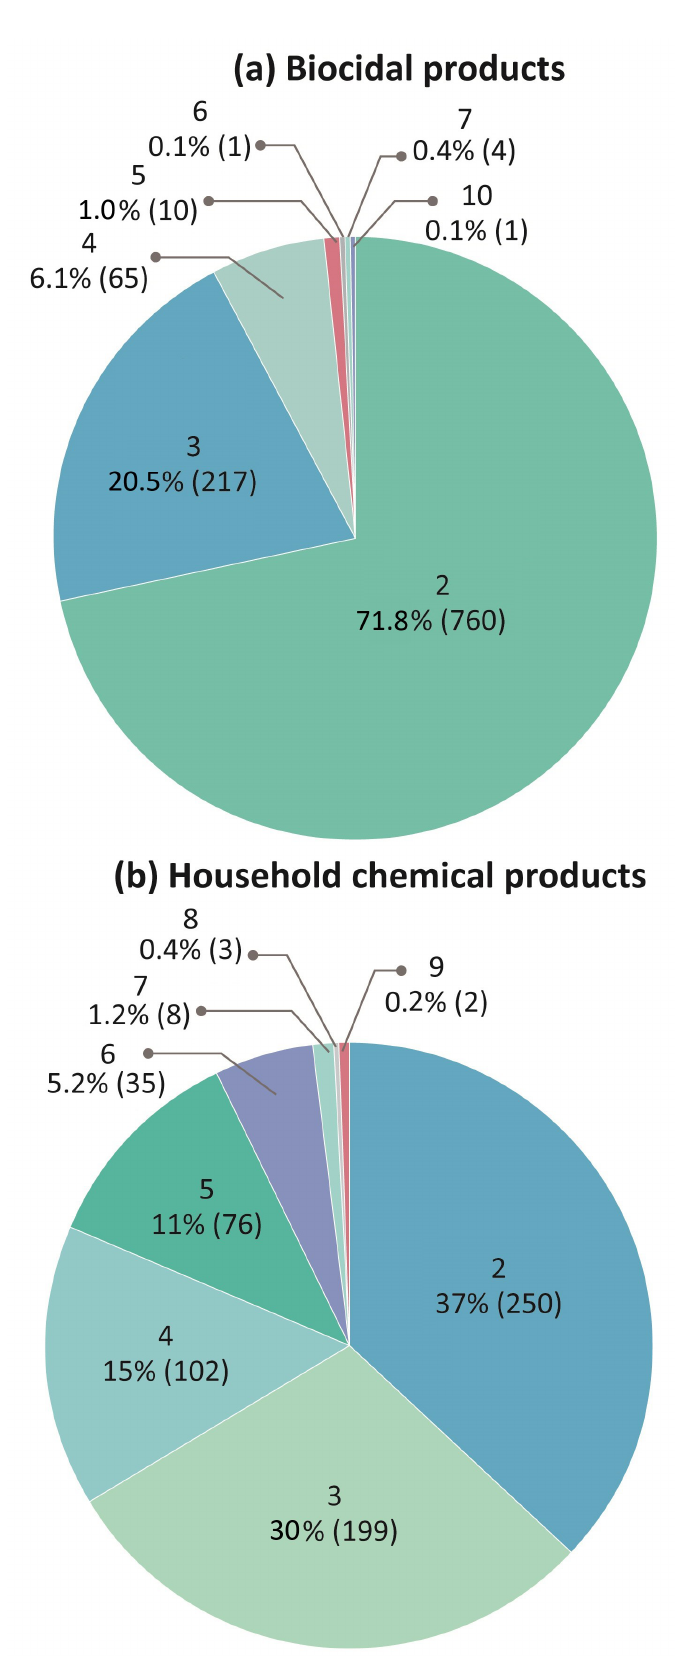
Figure 1. Distribution of the specific product category ( a ) biocidal products; ( b ) household chemical products which have biocidal active substances in the combined inhalation exposure scenario data of biocides in South Korea investigated in this